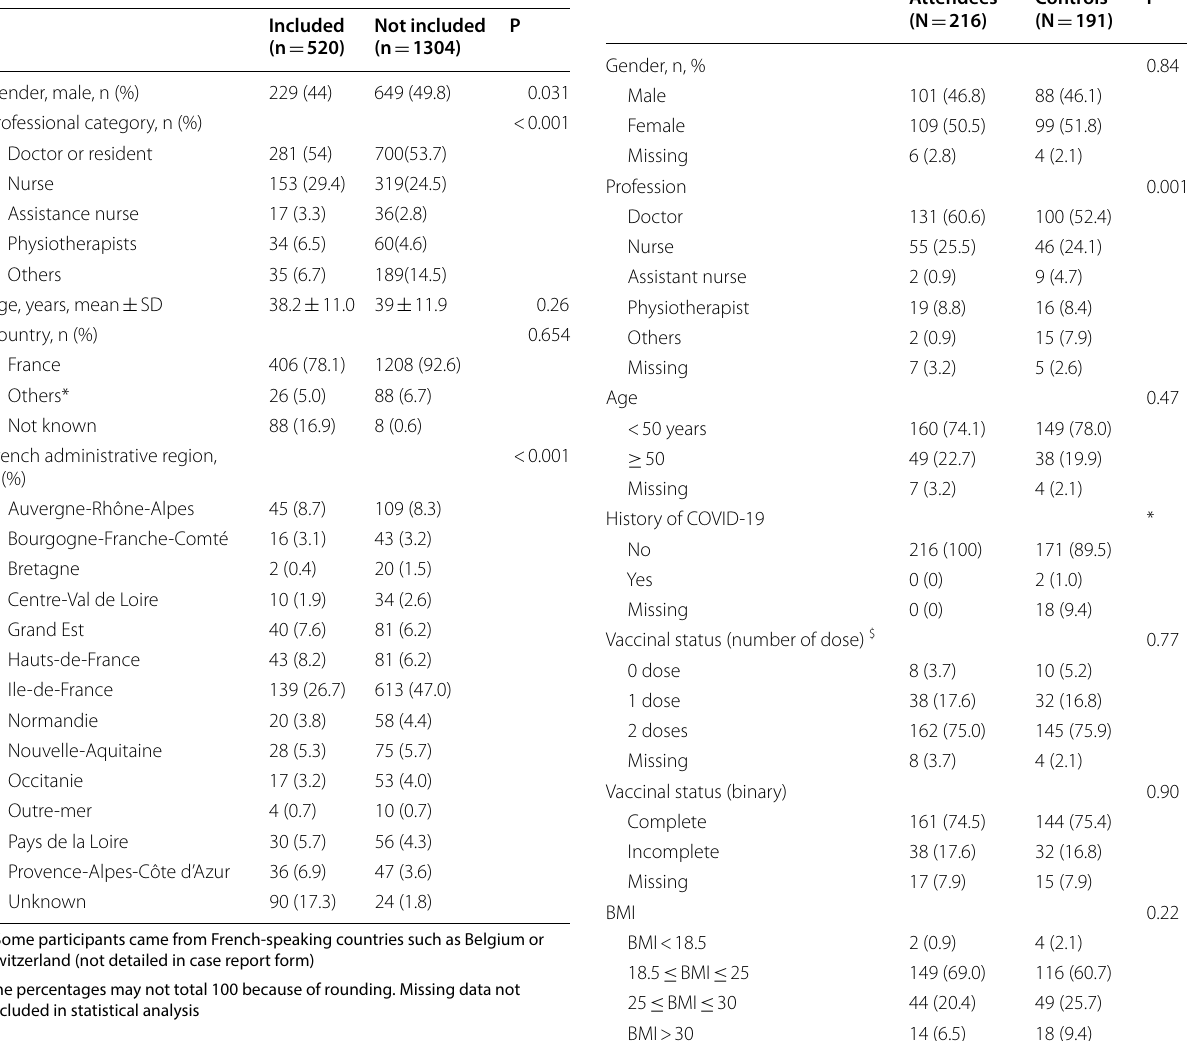
Table 1 Comparison of included and not included participants of the congress